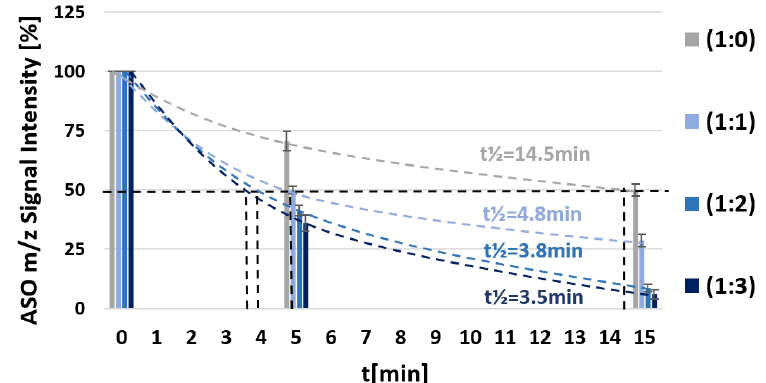
Figure 7. Autoradiograms after denaturing PAGE, showing the products of svPDE-promoted hydrolysis of 32 P-labeled oligonucleotides 1 or 2 mixed with metallacarborane ferra(III) bis(dicarbollide) (6 molar equivalents relative to ASO). Lanes 1 to 6 represent the products present in aliquots of the hydrolysis reaction taken at 0, 5, 15, 30, 60 and 90 min, respectively.